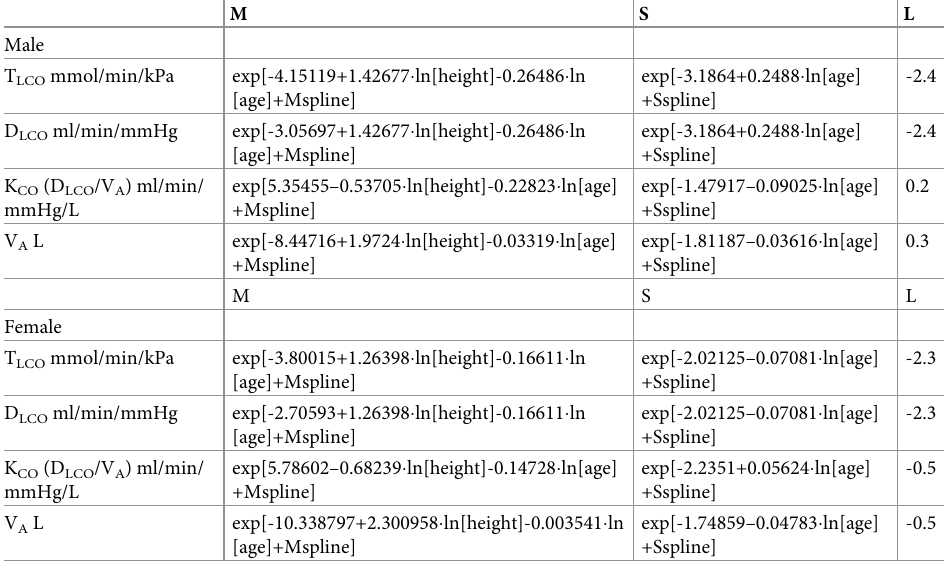
Table 4. Corrected equations for the predicted values for the median (M), the variability around the median (S), and the skewness (L) for each of the D LCO test outcomes. M S L Male T LCO mmol/min/kPa